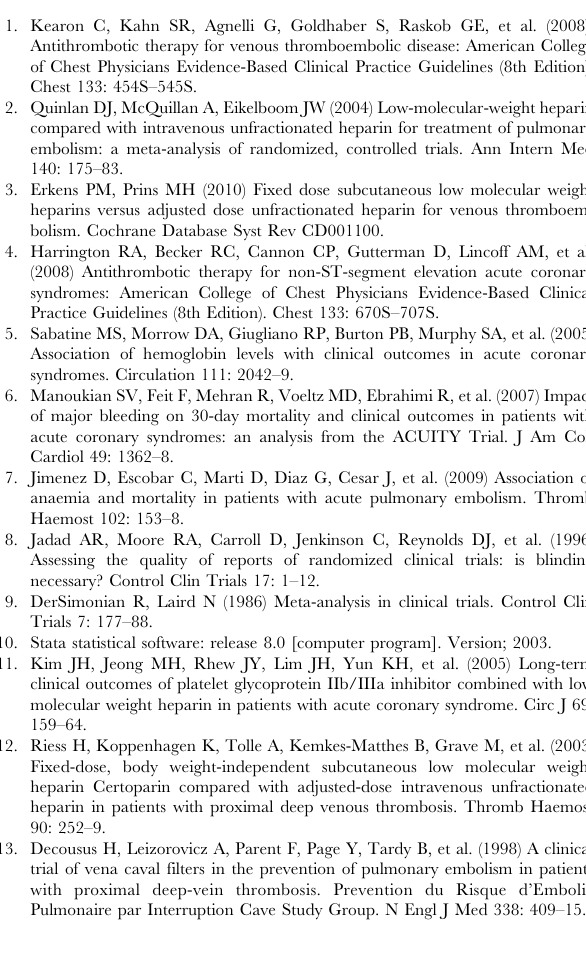
Figure S2 Subgroup analysis: number of daily LMWH administrations (once daily vs twice daily) in VTE and ACS studies. Figure S3 Subgroup analysis, after the exclusion of studies in which LMWH was was under-dosed (less than 75% of the recommended daily dose) or overdosed (more than 125% of the recommended dose). Figure S4 Subgroup analysis by type of LMWH. Figure S5 Subgroup analysis, after exclusion of low quality studies (Jadad Score , 3). Figure S6 Overall meta-analysis, including dose-finding studies (studies grouped by VTE or ACS